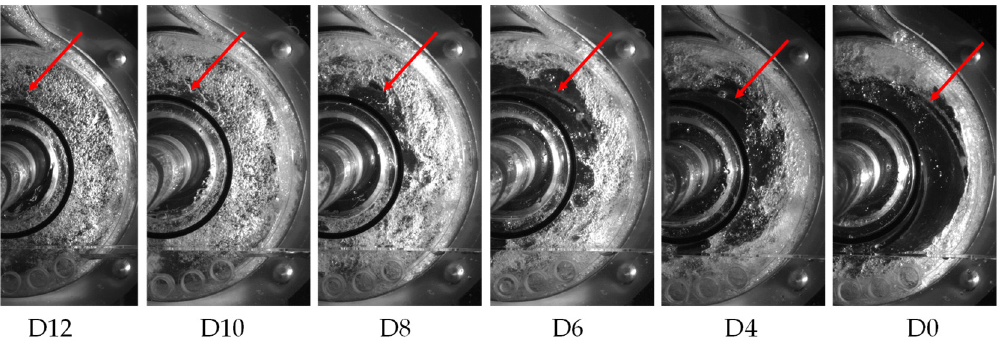
Figure 9. Gas–liquid distribution in the pump at 10 s.